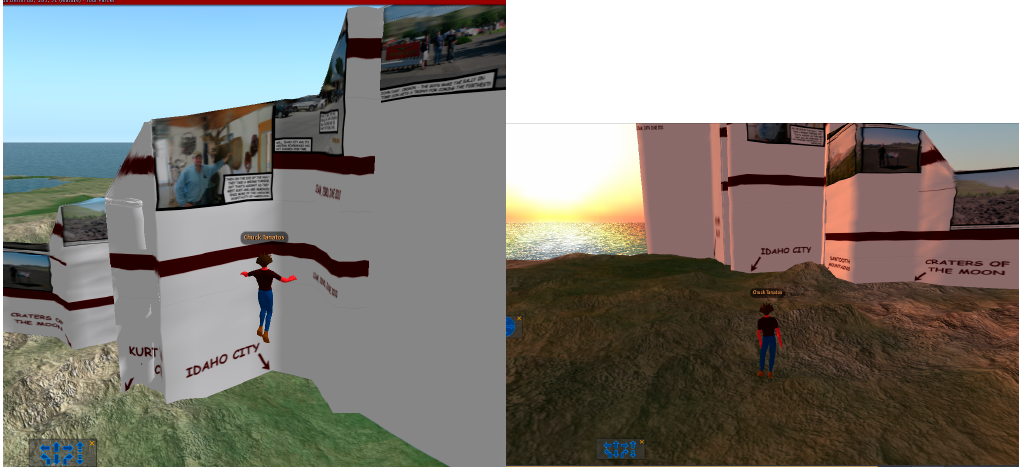
Figure 7. ( left ) The avatar exploring the situated photo comic strip in OpenSim, in this instance in the direction of the route travelled; ( right ) The avatar following the reverse direction story, a narrative using the same photos but “looking back” on the trip.